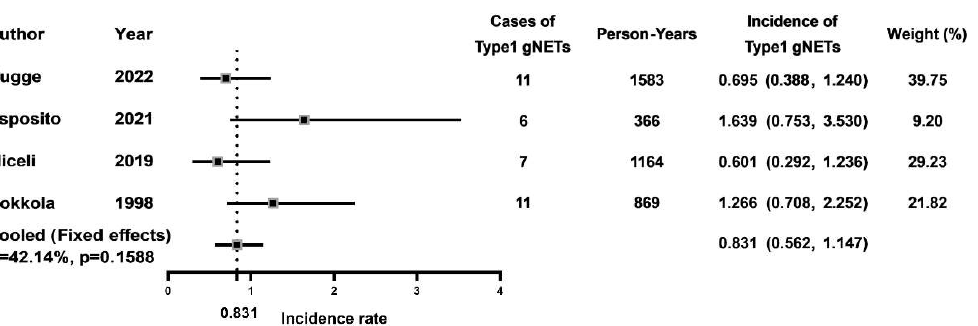
Figure 4. Incidence rates of type-1 gNETs in AMAG patients